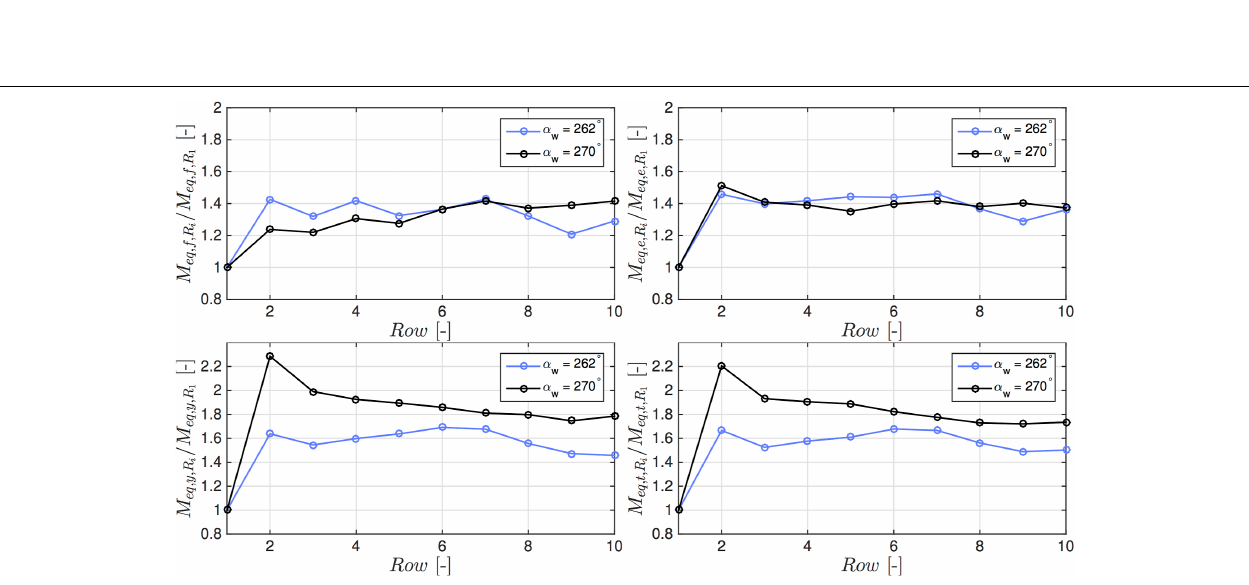
Frontiers in Energy Research |